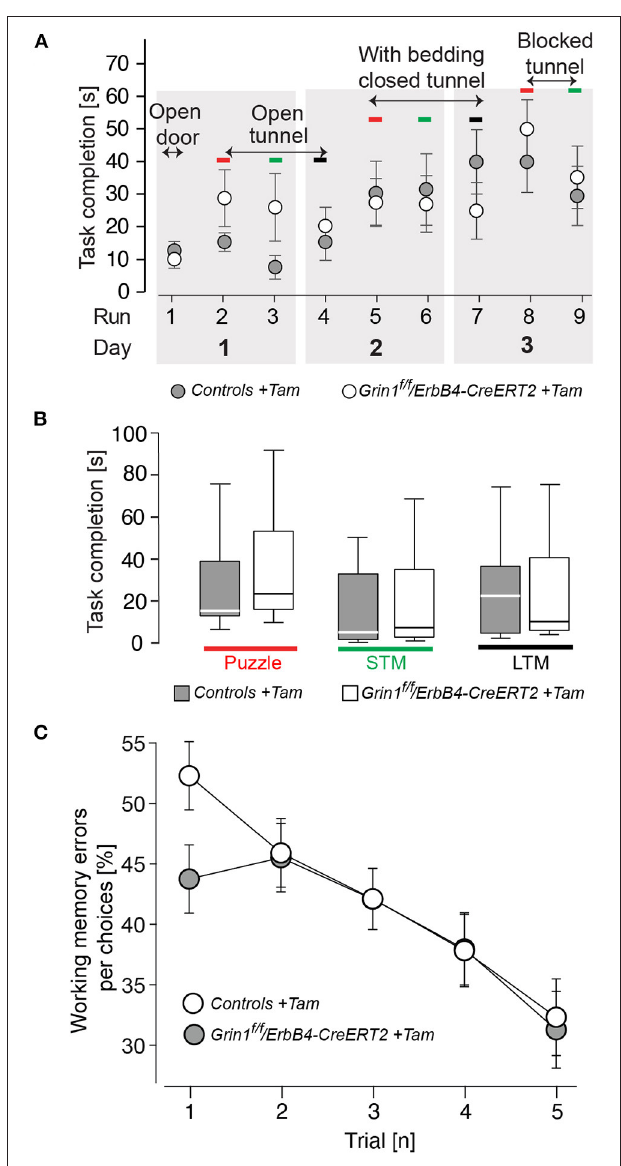
FIGURE 5 | Mutant mice showed no impairments in learning and puzzle solving. (A) Time to complete the puzzle per trial due to condition. (B) Puzzle, analysis of the recognition of a novel task; STM, short-term memory (repetitive task on the same day); LTM, long-term memory (repetitive task of the last day). (C) Working memory errors in the radial maze in 5 consecutive trials (1 tial = 2 runs). Controls are shown in black, Grin1 1 ErbB 4 f / f // ErbB 4 − CreERT 2 in white. Group size n = 14. Data is represented as means +